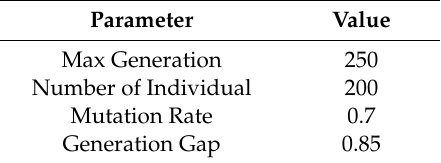
Table 3. The parameters in the genetic algorithm (GA) program.